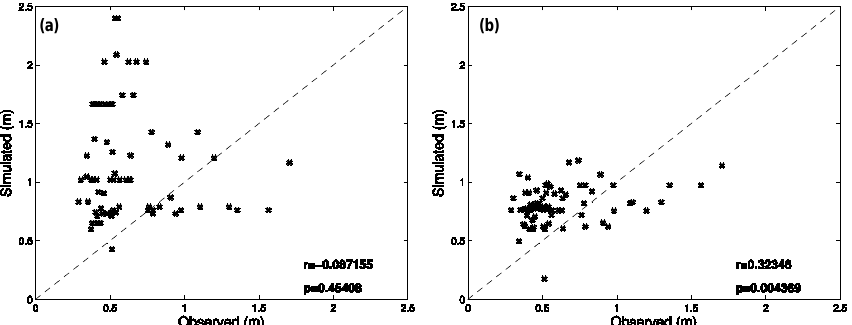
Figure 2. Comparison of ALT from 76 Circumpolar Active Layer Monitoring stations with the averaged ALT from the last 5 years after spin-up from (a) Schaefer et al. (2011) and (b) this study. r is a Pearson’s correlation coefficient and p is a significance value; p <0.05 stands for the 95% confidence level.